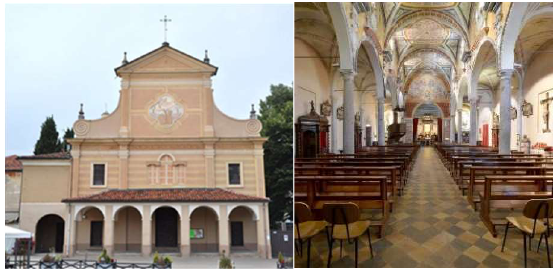
Figure 2a and b. Facade and naves of the Church.